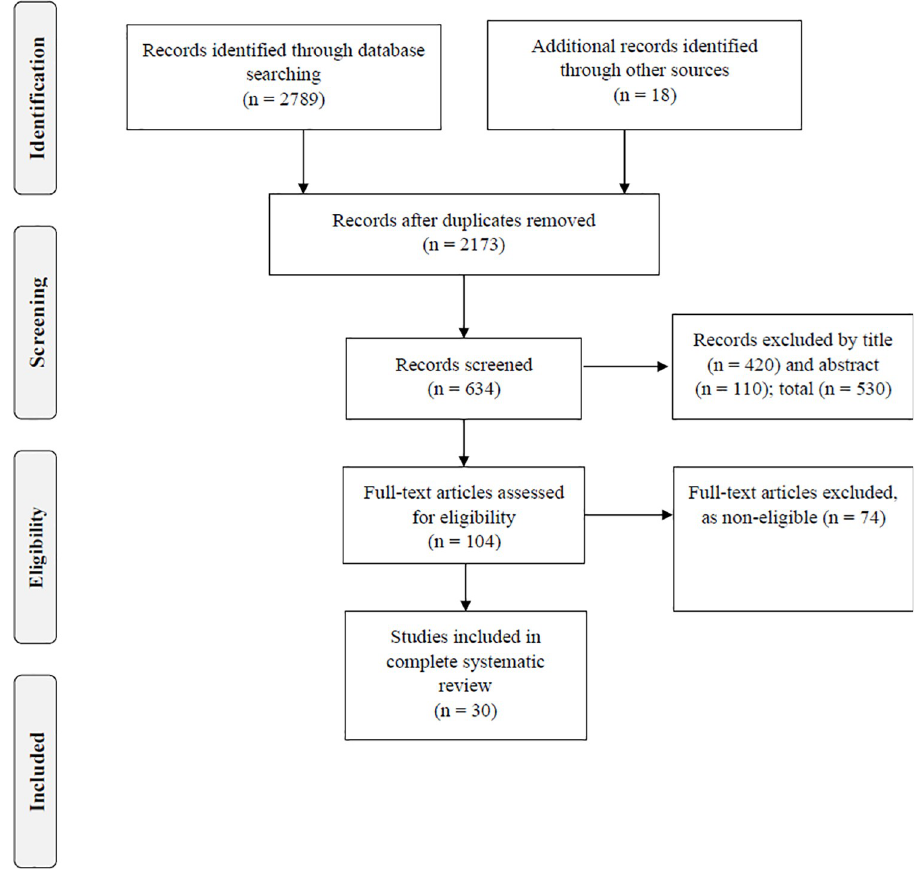
Fig 1. PRISMA flow diagram for the selected